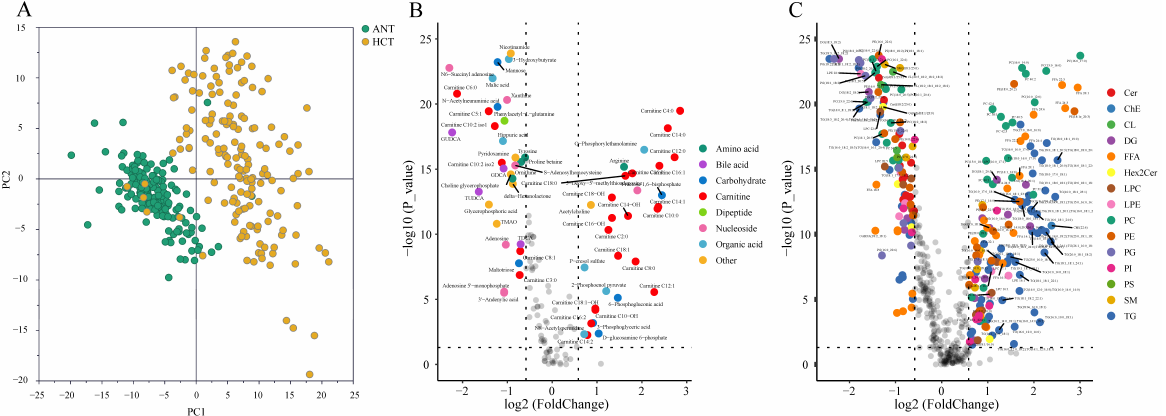
Figure 1. Comparative metabolomics and lipidomics profiles of adjacent noncancerous tissue (ANT) and hepatocellular carcinoma tissue (HCT) samples from HCC patients. ( A ) Score plot of PLS-DA model for ANT samples (orange dots) and HCT samples (green dots) separation (R2X = 0.177, R2Y = 0.755, Q2 = 0.71). Volcano plots of metabolomics ( B ) and lipidomics data ( C ) discriminating ANT and HCT samples. Log2 fold change values of normalized mean peak area are plotted against the respective − log10 transformed p values. Ion features with adjusted p < 0.05 were considered as significantly differential expression. The metabolites with |fold change| > 1.5 and lipids with |fold change| > 2 are highlighted with compound name. Detected compounds were compared using a Wilcoxon Signed-rank test for matched samples and the raw p values were adjusted to false discovery rate (FDR) using the Benjamini–Hochberg